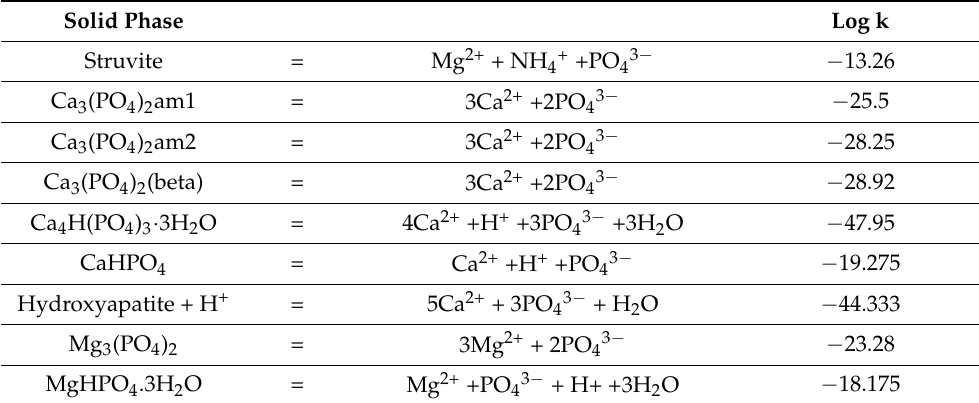
Table 3. Precipitation reactions used in the construction of the activity ratio solubility